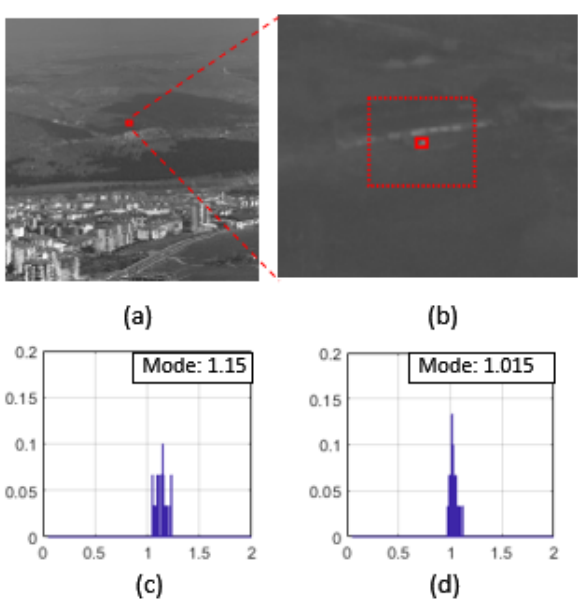
Figure 3. Deleted Detection and Distribution of Reflectance Ratios: (a) Zoom-Out Image Patch, (b) Candidate Object & Surroundings, (c) Distribution of the Candidate, (d) Distribution of the Surroundings